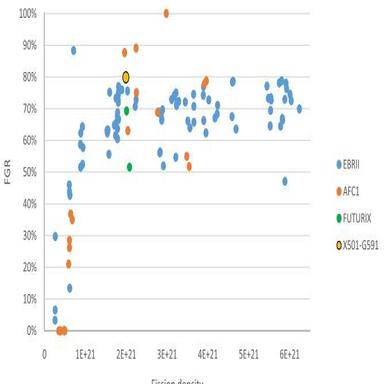
Fission gas release versus fission density for X501-G591, AFC-1, FUTURIX-FTA (metallic alloys), and the historic EBR-II database (reproduced and modified from Ref.). The average value of fission density (from was used for X501-G591.